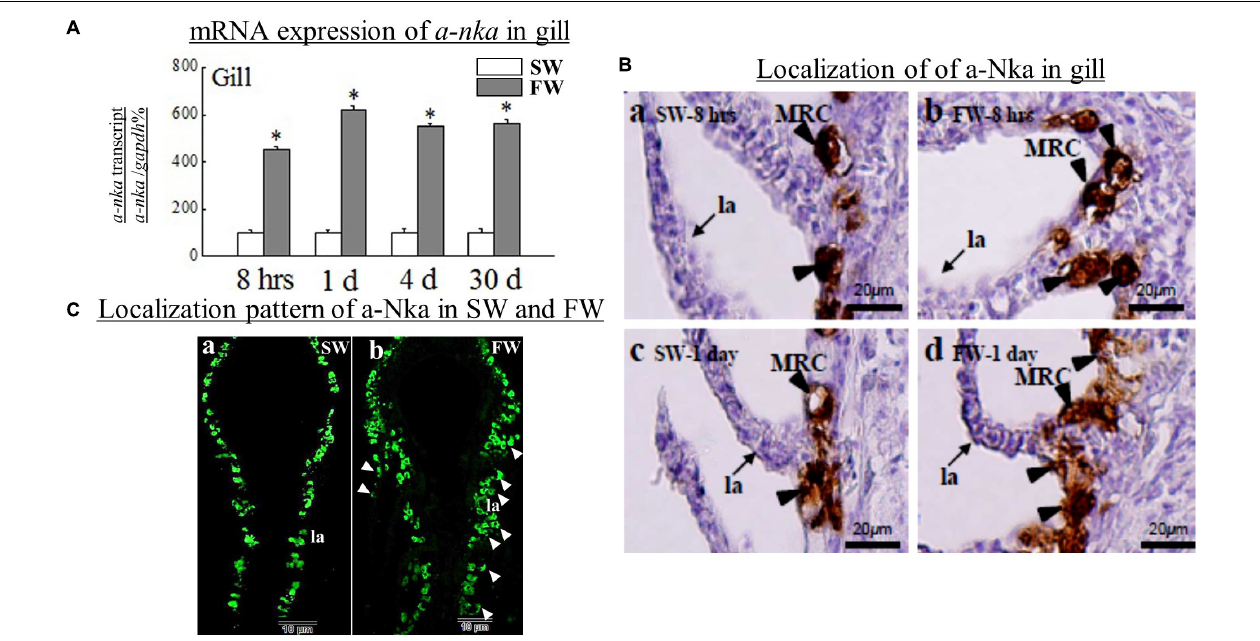
FIGURE 3 | (A) Comparative analysis of a-nka , gene expressions as determined by quantitative real-time PCR in diencephalon (Dien) of black porgy from SW to FW at 8 h, day 1, day 4, and day 30. Each data had 10 fish. (B) The immunohistochemistry was performed to localize the a-Nka cells in black porgy gill during SW and FW acclimation on day 1 and day 30. The expression of a-Nka in the gill was increased in FW at 8 hrs (b) and day 1 (d) compared to the respective SW fish (a,c) . The Nka was expressed in the filaments and lamellae in the FW fish (b,d) but the a-Nka was expressed only in the gill filament not lamellae in SW fish (a,c) . The representative fish is shown from one of 3 fish. There were no notable signals found in the control (not shown). (C) Localization pattern of a-Nka cells during SW (a) and FW (b) of black porgy. The a-Nka cells were also appeared in the lamellae (pointed with arrow heads) in addition to filament in FW fish (b) . MRC: mitochondria rich cell, fi: filament, la: lamellae. Student’s t -test was conducted to determine significant differences ( p < 0.05) between SW and FW denoted by asterisks (*).